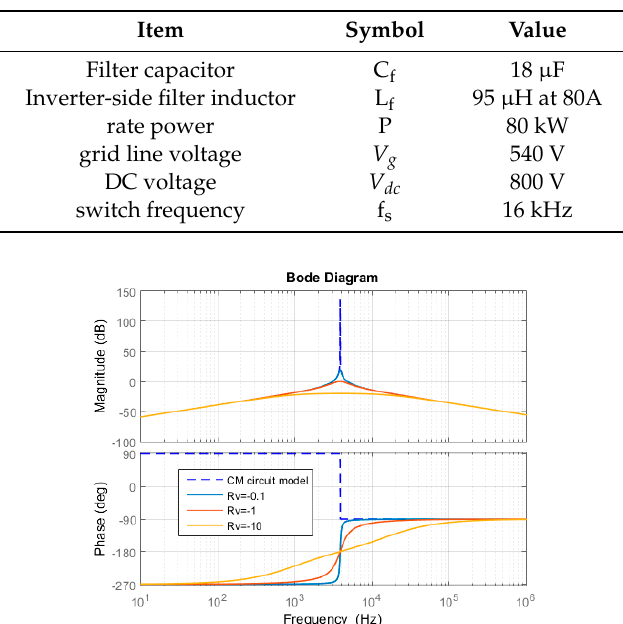
Figure 7. Bode diagram of CM power stage: without R v and with R v connected in series with L f.